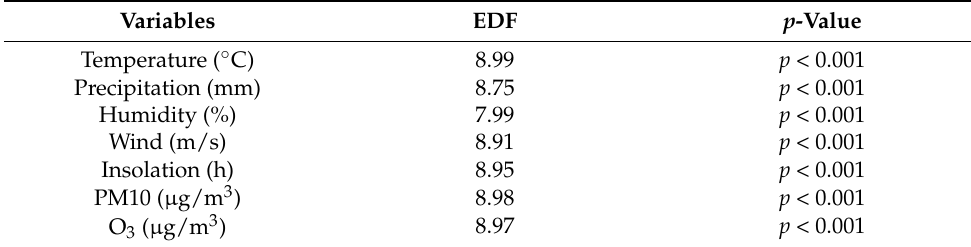
Table 3. Generalized additive model results.